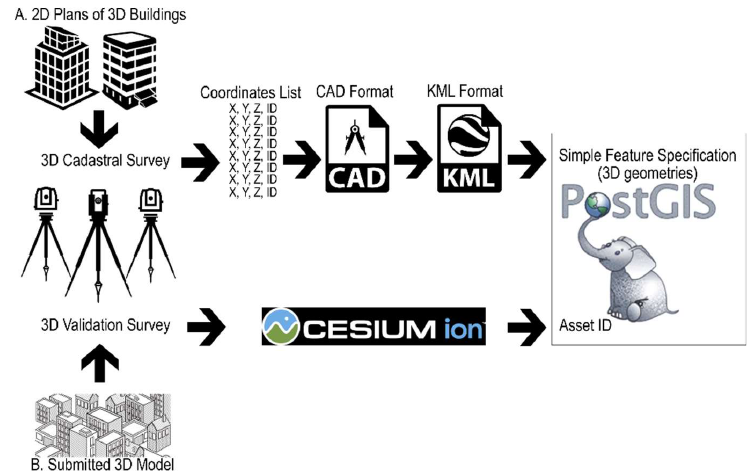
Figure 4. Data processing flow.